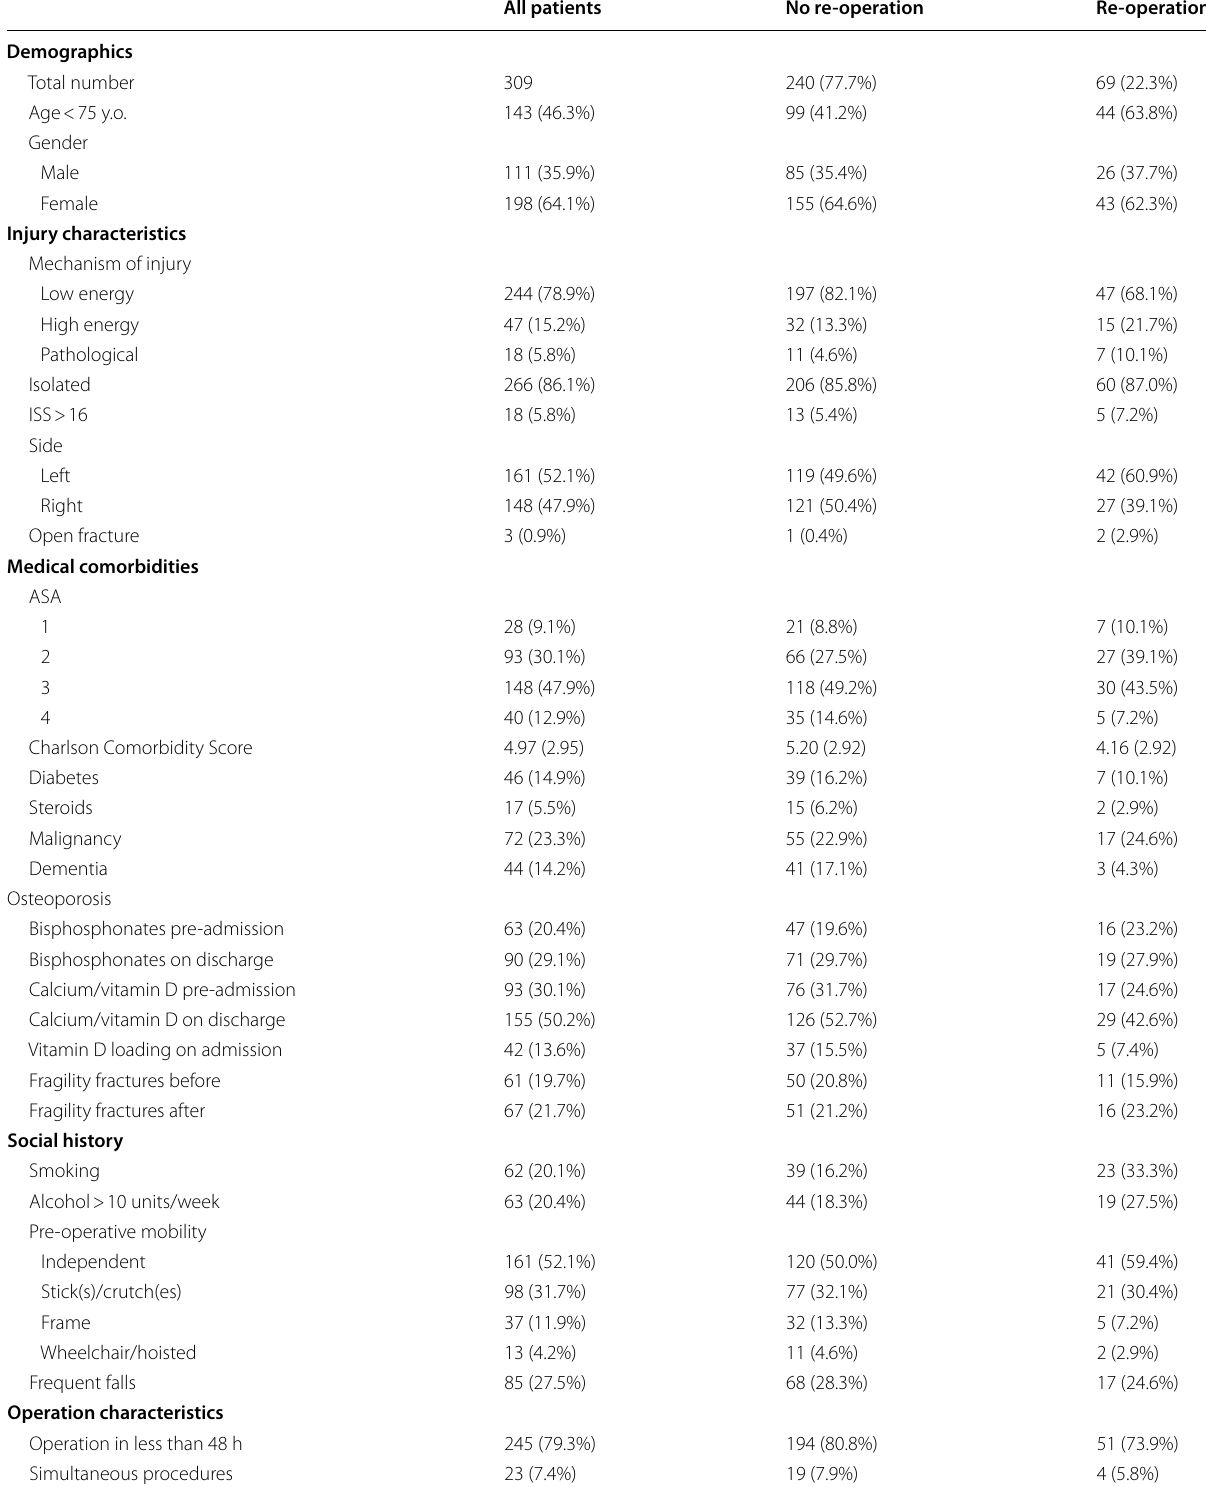
Table 1 Demographics/characteristics of patients with a subtrochanteric fracture treated with a long cephalomedullary nail, stratified according to re-operation All